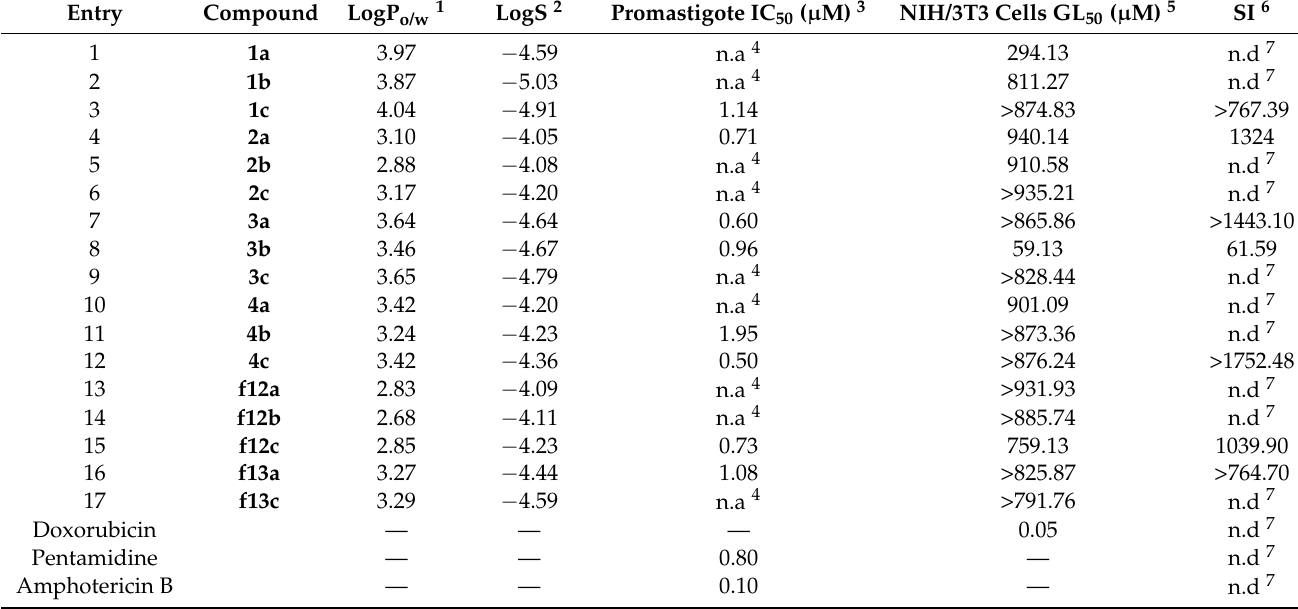
Table 6. Molecular LogP, LogS, in vitro antileishmanial activity and cytotoxicity of flavonoid